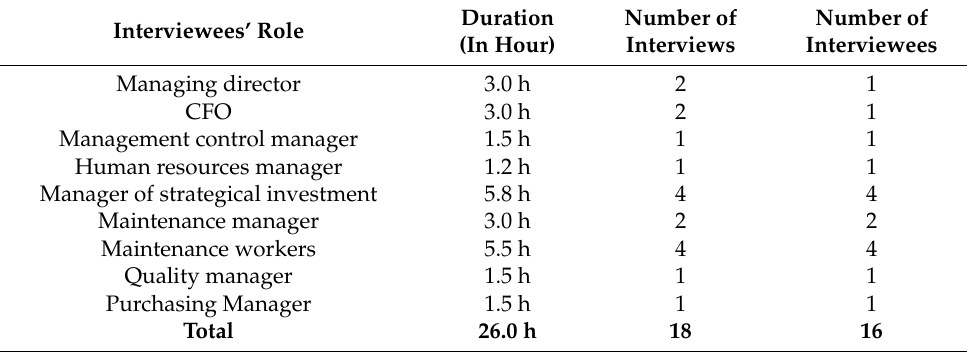
Table 2. Interviewees by